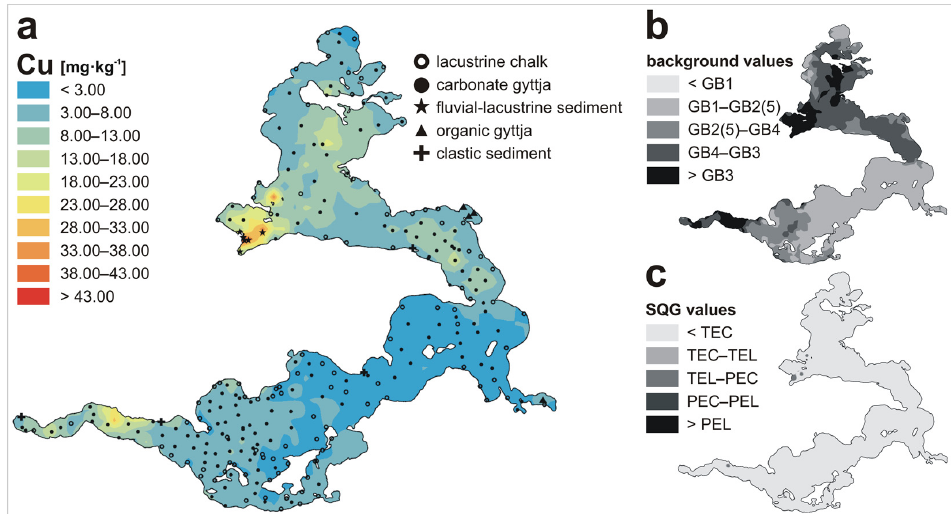
Figure 7. Copper in recent bottom sediments of the Wigry Lake: ( a ) spatial distribution of Cu; ( b ) Cu mapped according to different geochemical background values implemented in the study (Table 3); ( c ) Cu mapped according to sediment quality guideline values (TEL—threshold effect level, TEC— threshold effect concentration, PEL—probable effect level, PEC—probable effect concentration [59,60]; Table 3).